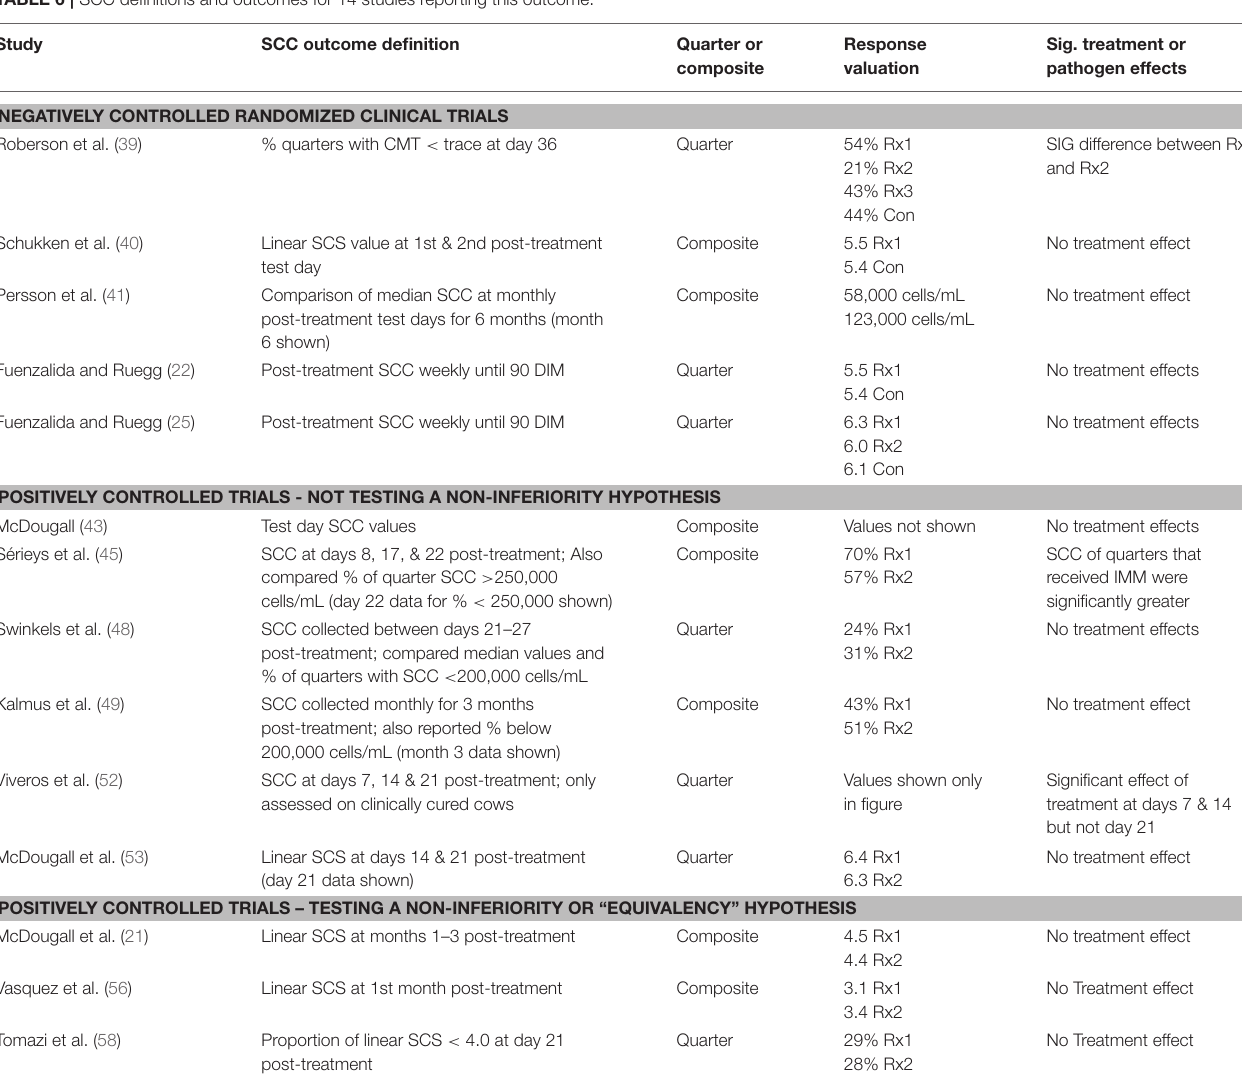
TABLE 6 | SCC definitions and outcomes for 14 studies reporting this